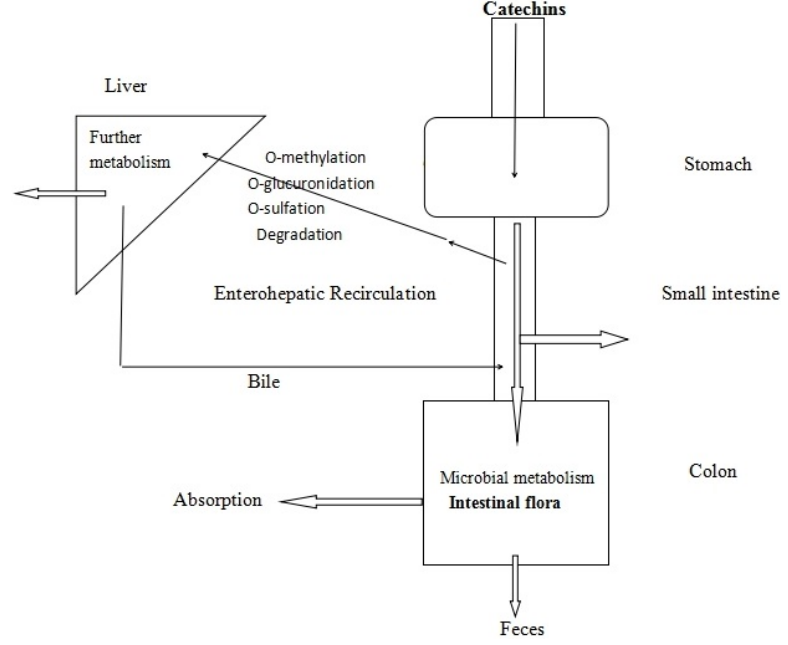
Figure 3. Supposed metabolism of green tea catechins in humans.